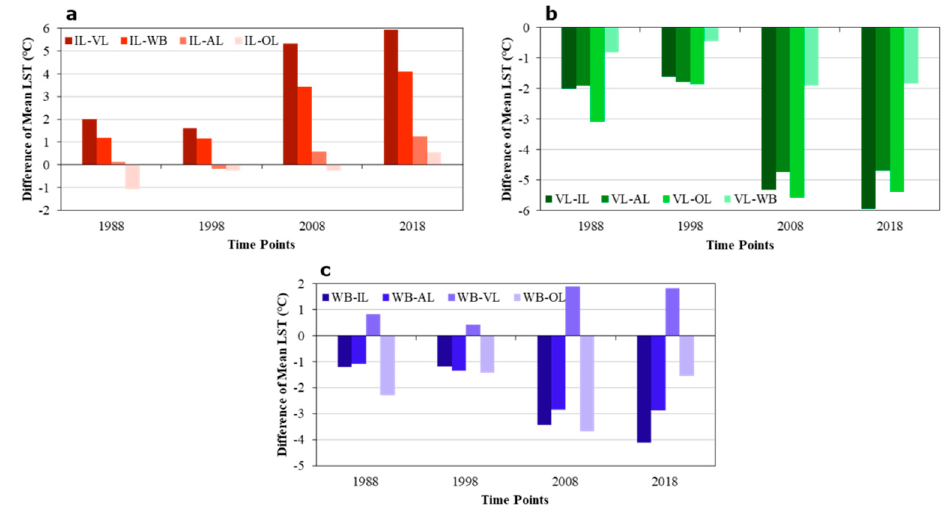
Figure 6. Di ff erences in mean LST between LULC classes in Kathmandu Valley (1988–2018), Figure 6. Differences in mean LST between LULC classes in Kathmandu Valley (1988–2018), ( a ) ( a ) Impervious Land vs. other LULC classes; ( b ) Vegetation Land vs. other LULC classes; ( c ) Impervious Land vs other LULC classes; ( b ) Vegetation Land vs other LULC classes; ( c ) Water Body Water Body (WB) vs. other LULC classes. (WB) vs other LULC classes.